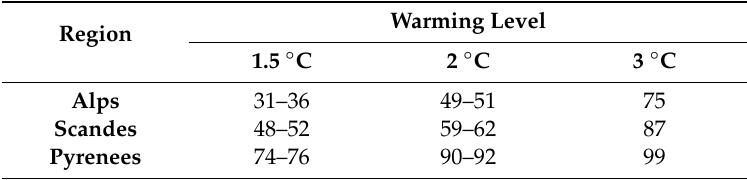
Figure 5. Projected changes of the alpine tundra domain (ATD) in the Alps under scenario RCP4.5 and RCP8.5 in three warming levels with respect to the reference period (1981–2010). Table 4. Projected relative contraction (including the categories confident and likely contraction) of the alpine tundra domain (ATD) in three warming levels (1.5 ◦ C, 2 ◦ C and 3 ◦ C). Changes with respect to the extent of the ATD in the reference period (1981–2010) in three regions: Alps, Scandes and Pyrenees. Ranges computed according to the projected contraction in RCP4.5 and RCP8.5